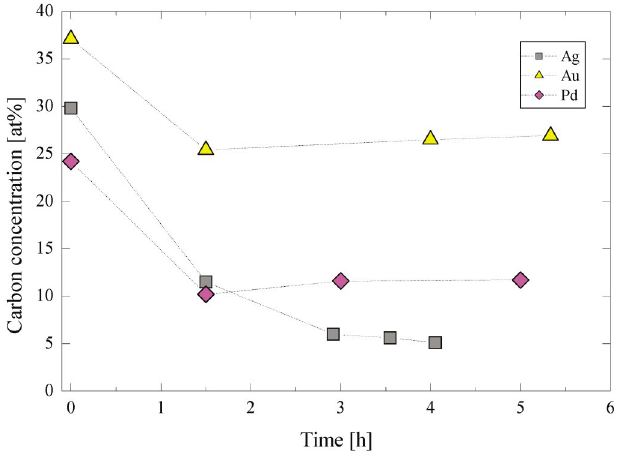
FIG. 8. (Color) Oxygen surface concentration of Ag, Au, and Pd coated stainless steel during a 300 (cid:7) C bakeout in